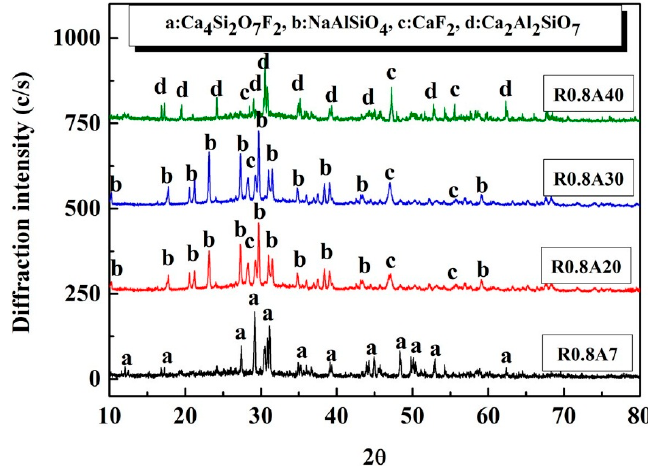
Figure 13. The XRD of mold fluxes with different amounts of Al 2 O 3 .